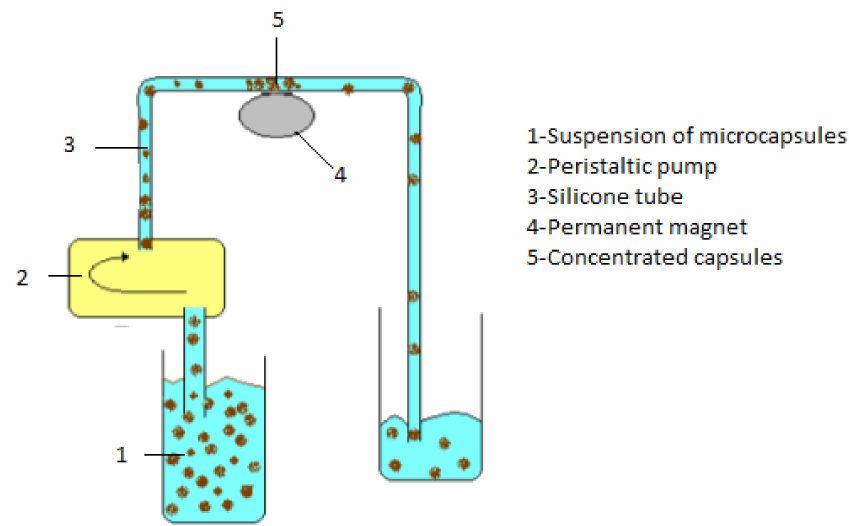
Figure 1. Experimental design: the microcapsules accumulate in the tube above the